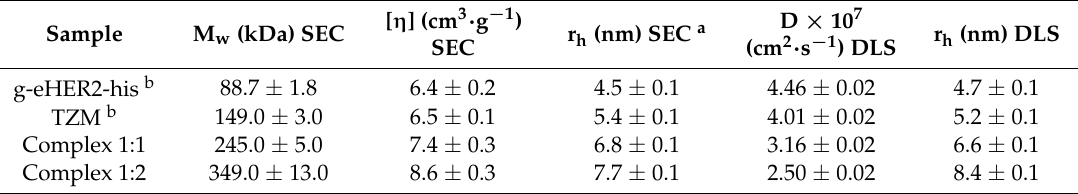
Table 1. Experimental molecular and hydrodynamic results for the structures